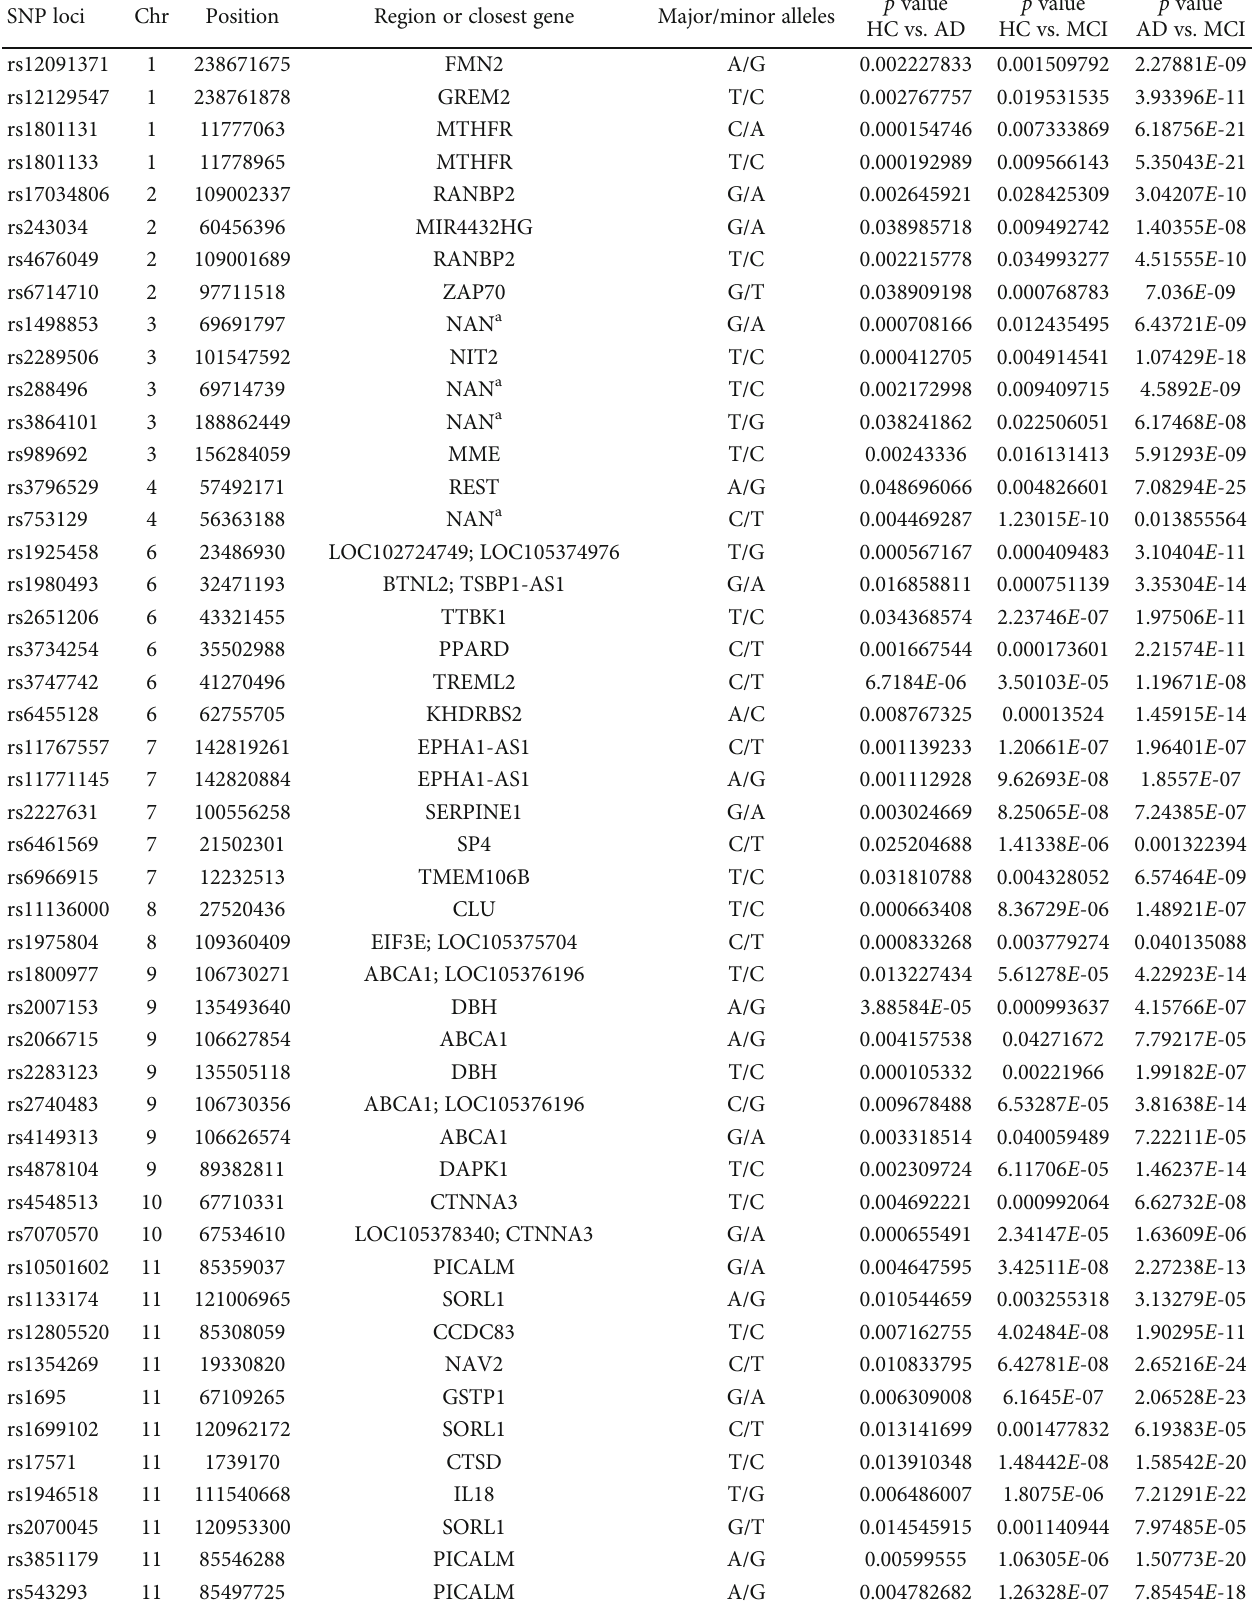
Table 4: Shared signi fi cant SNPs in AD multitasking classi fi cation at p threshold of